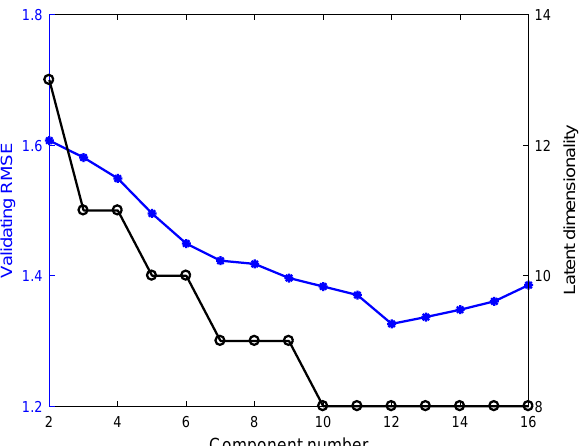
Figure 10. The validating RMSE and latent dimensionality based on